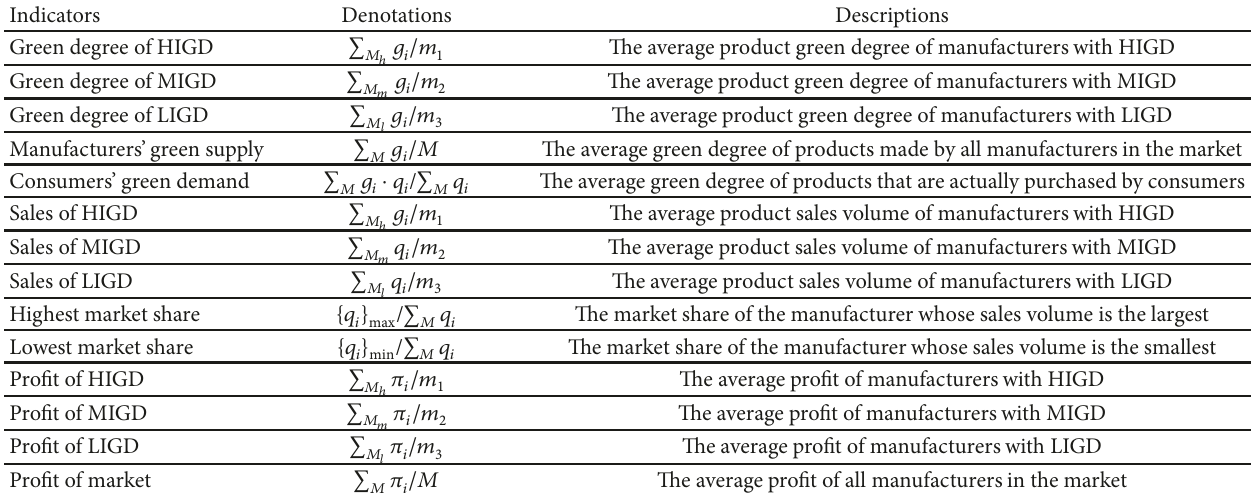
Table 3: Descriptions of